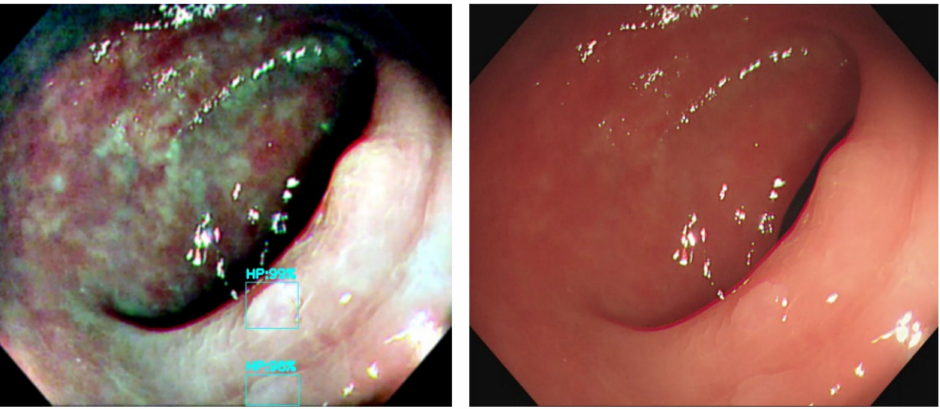
Figure 12. The correct results of MSRCR vs. the undetected polyp in original image. (( Left ): MSRCR, ( Right ): Original).